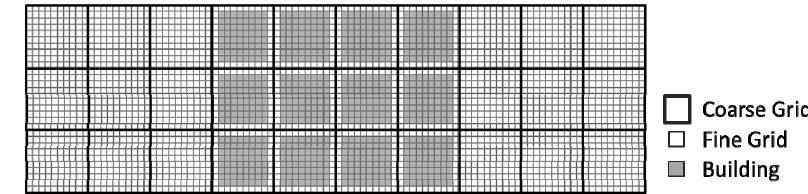
Figure 12. Simulation grid of 2D inundation model in real